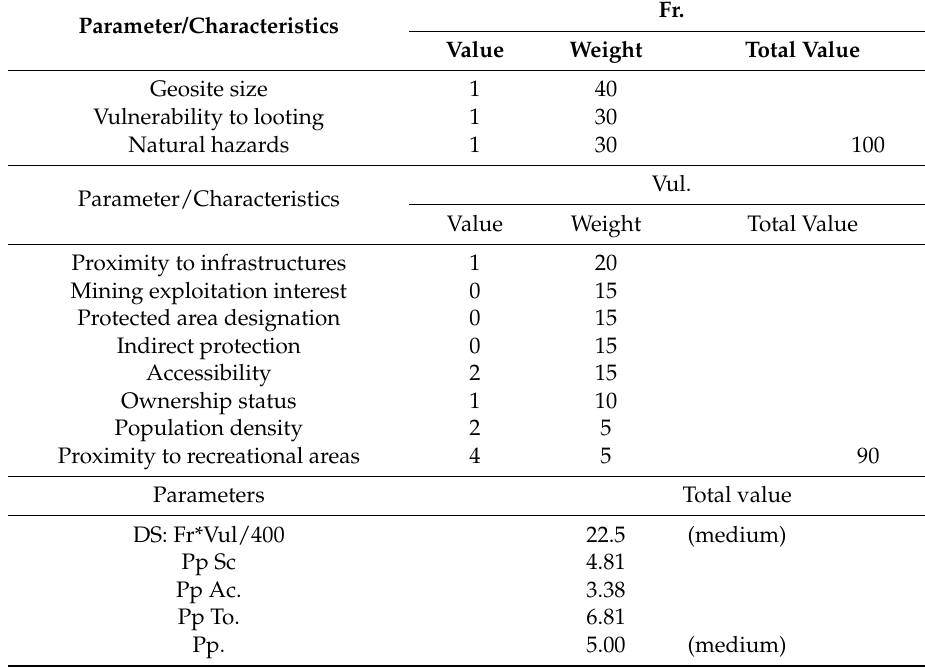
Table 2. Assessment procedure of the fragility (Fr.), vulnerability (Vul.) and degradation susceptibility (DS) of a particular site. The indicated values are a theoretical example. For Fr and Val., values range from 0 to 4. Weight (constant values in %). Interpretation of DS: Very high (200–400), High (68–199), Medium (13–67), Low (<13). Maximum (400). Interpretation of Pp: Very high (113–400), High (17–113), Medium (1–16), Low (0). Maximum (400). Modified from